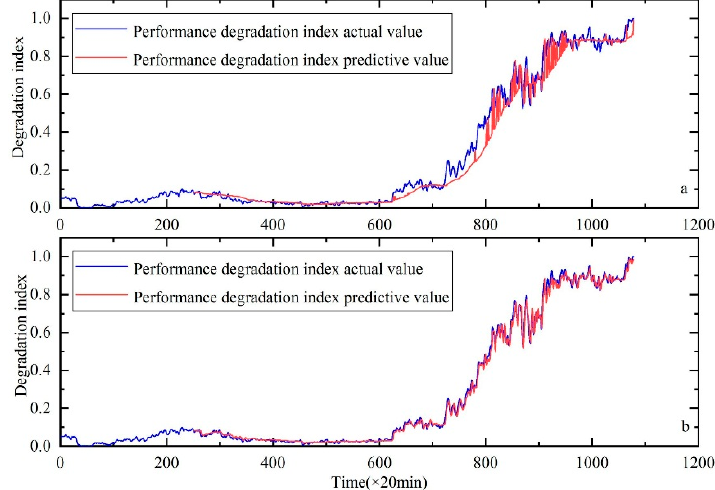
Figure 13. Performance degradation prediction of bearing 4, ( a ) is the result of HKF–SVR with parameters optimized by the GA and ( b ) is the result of HKF–SVR with parameters optimized by KH Table 6. Prediction errors comparison.